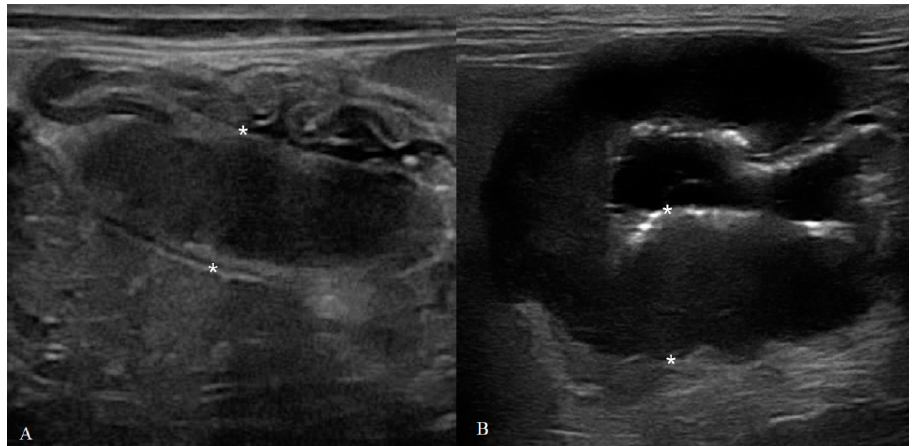
Figure 6. Different localization in gastric feline HGAL: ( A ) focal: a 7-year-old cat with a transmural mass (11.4 mm) with mixed echogenicity and loss of wall layers; ( B ) diffuse: severe hypoechoic thickening (20.8 mm) of gastric body with complete loss of normal layers in a cat 12-year-old cat.